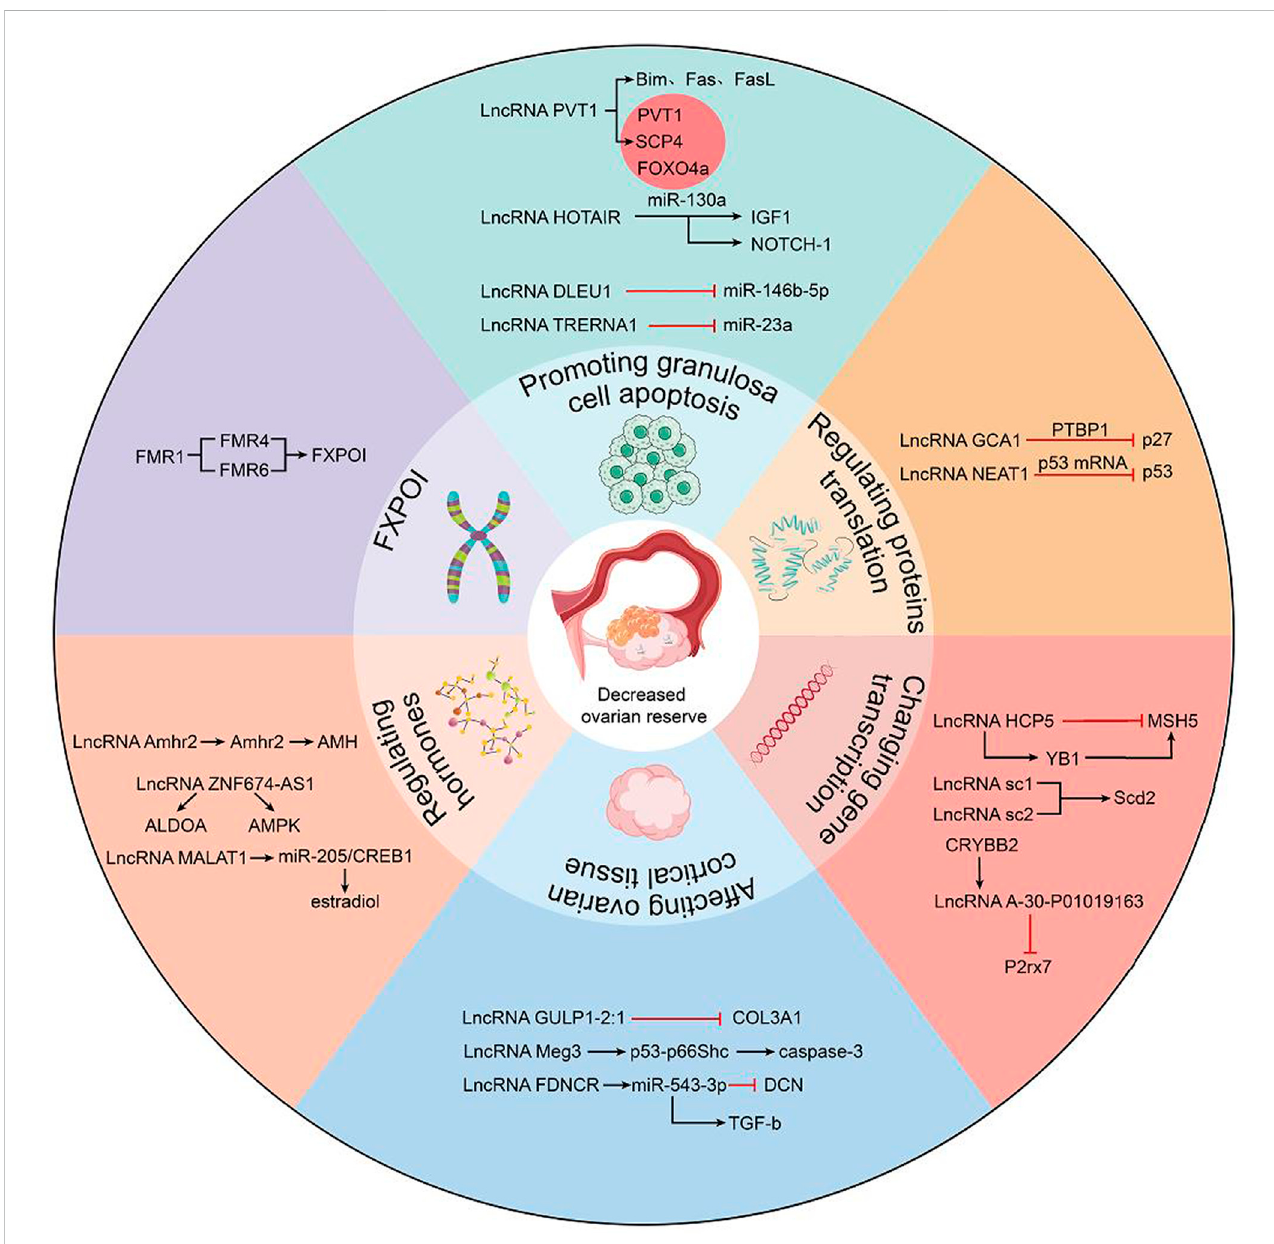
FIGURE 1 Role of lncRNAs in the pathogenic mechanism of human DOR. LncRNAs may affect ovarian function through the following mechanisms: forming lncRNA-ceRNA networks to regulate transcription of upstream or downstream genes and protein transcription, regulating hormones related to ovarian function by signaling pathways, affecting cortical tissue of ovary, and lncRNAs associated with